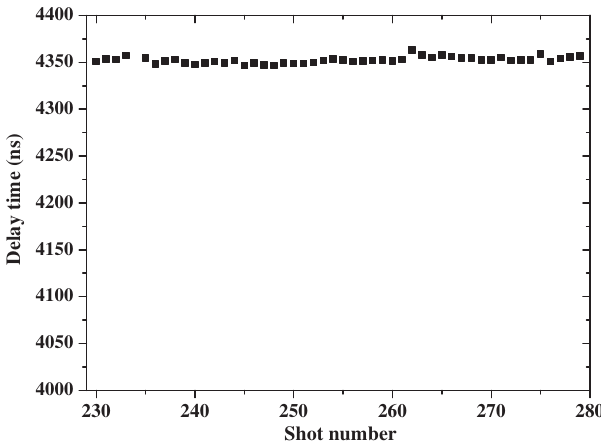
FIG. 17. Statistical delay times of Hawkeye-I for the 50 consecutive shots except for the failure